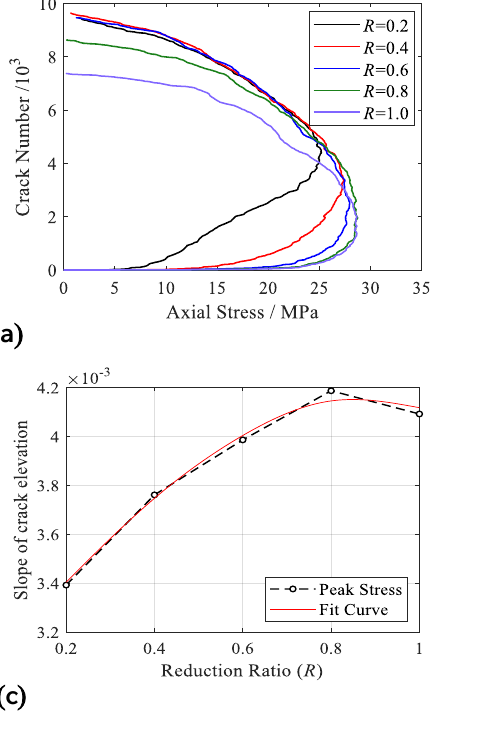
Figure 7. Crack properties. ( a ) Crack number—stress curve; ( b ) distribution of crack elevation ( R = 1.0); ( c ) slope statistics of crack elevation.